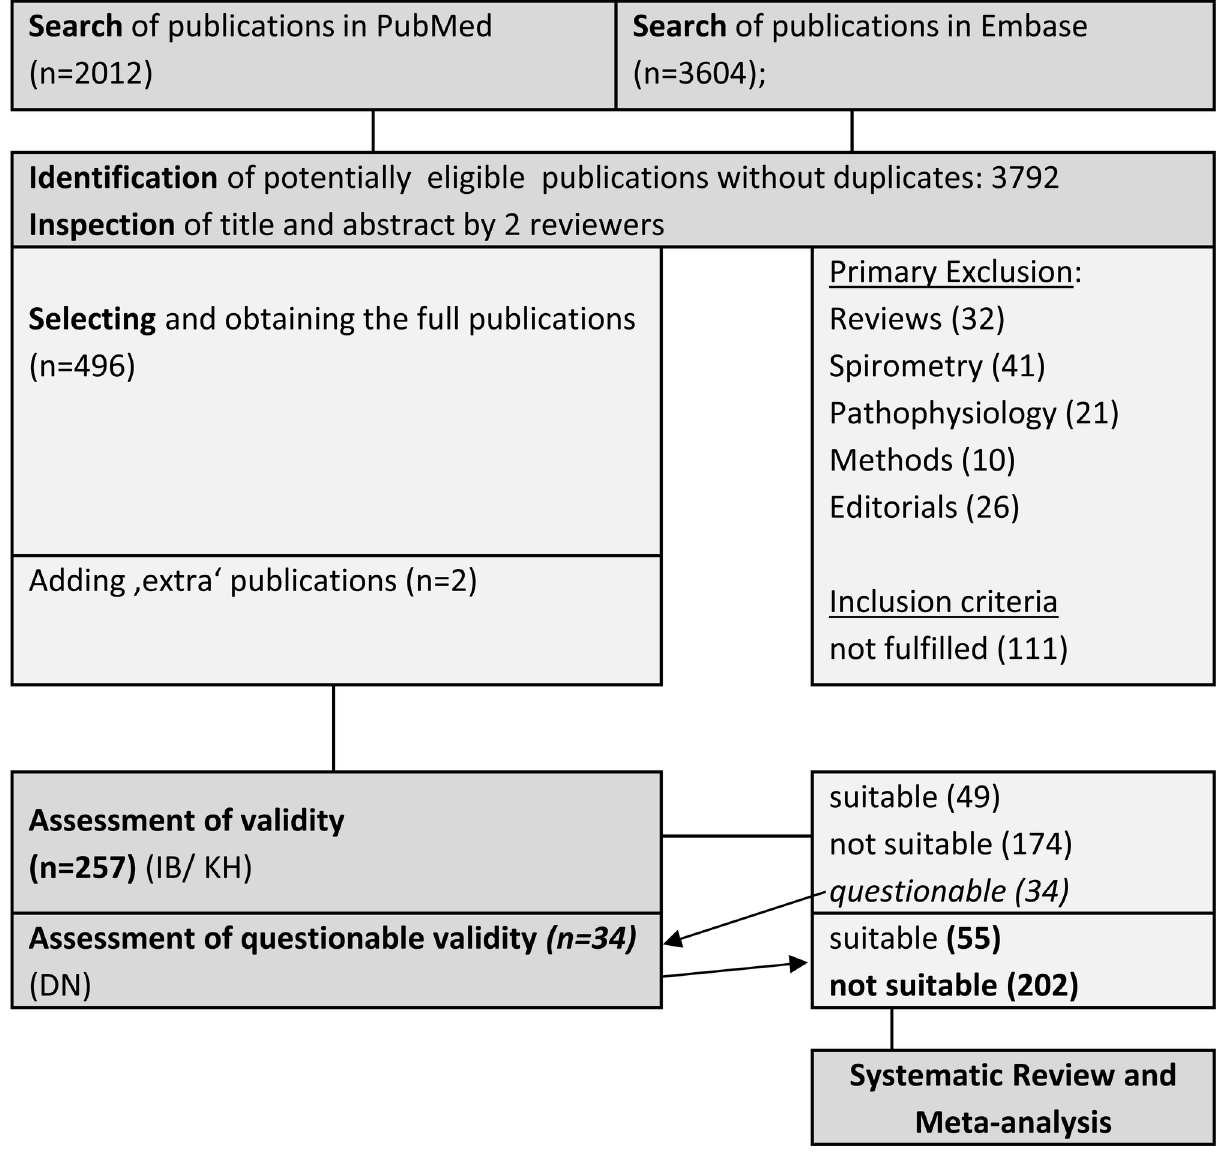
Figure 1. Flow chart of study selection for Systematic Review and